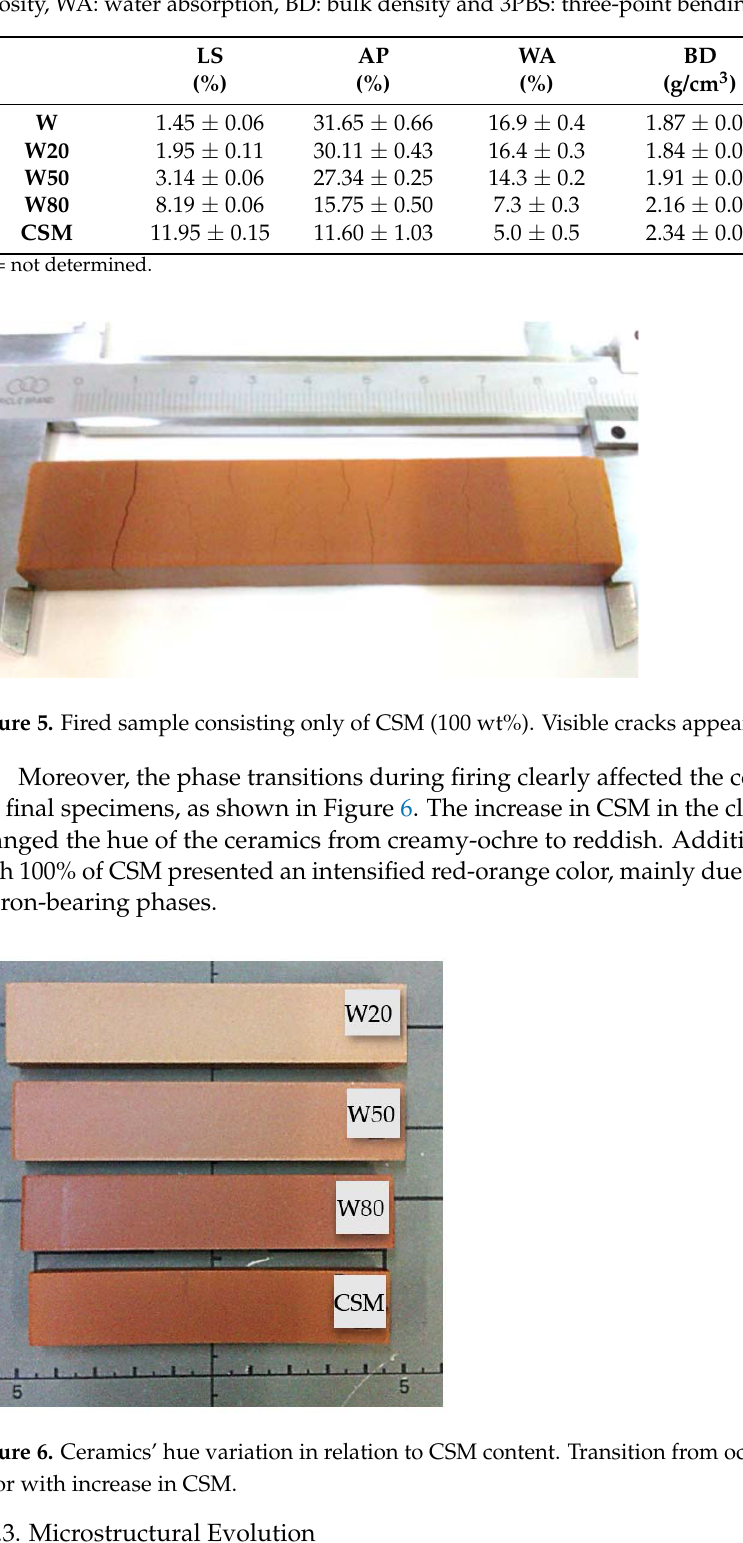
Table 2. Technological properties of fired samples. LS: linear shrinkage after firing, AP: apparent porosity, WA: water absorption, BD: bulk density and 3PBS: three-point bending strength.